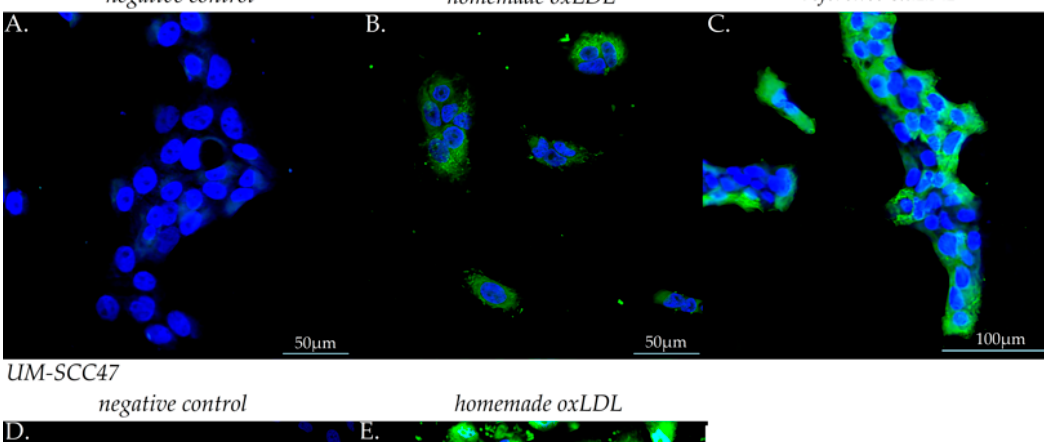
Figure 3. CD36 expression in 93VU-147T, UM-SCC47, and UPCI-SCC154 cell lines with or without oxLDL treatment (30 µg/mL, 48 h). Representative images and computed mean fluorescence inten- sities (MFI; 2 biological replicates in triplicate). ( A , H ) CD36 expression in 93VU-147T not exposed to oxLDL ( n = 10); ( B , H ) or exposed to home-made oxLDL ( n = 10); or ( C , H ) reference oxLDL ( n = 10). ( D , I ) CD36 expression in UM-SCC47 cells without oxLDL ( n = 10); or ( E , I ) exposed to home-